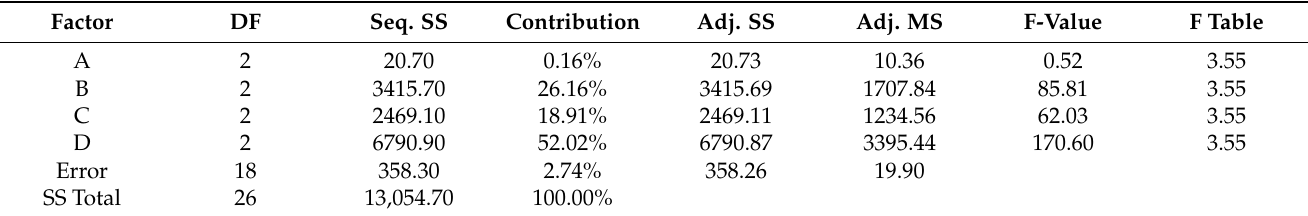
Table 6. The analysis of variance for tensile strength of SS316 and low-carbon steel weld joints.